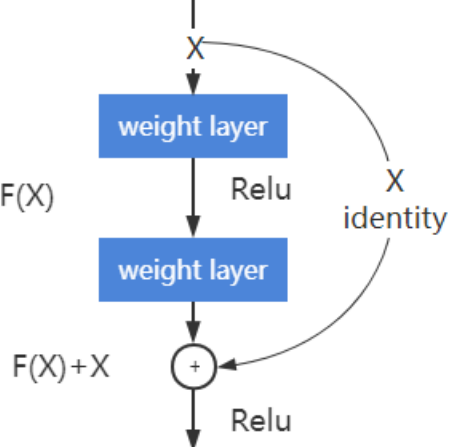
Figure 4. Building block of residual learning.